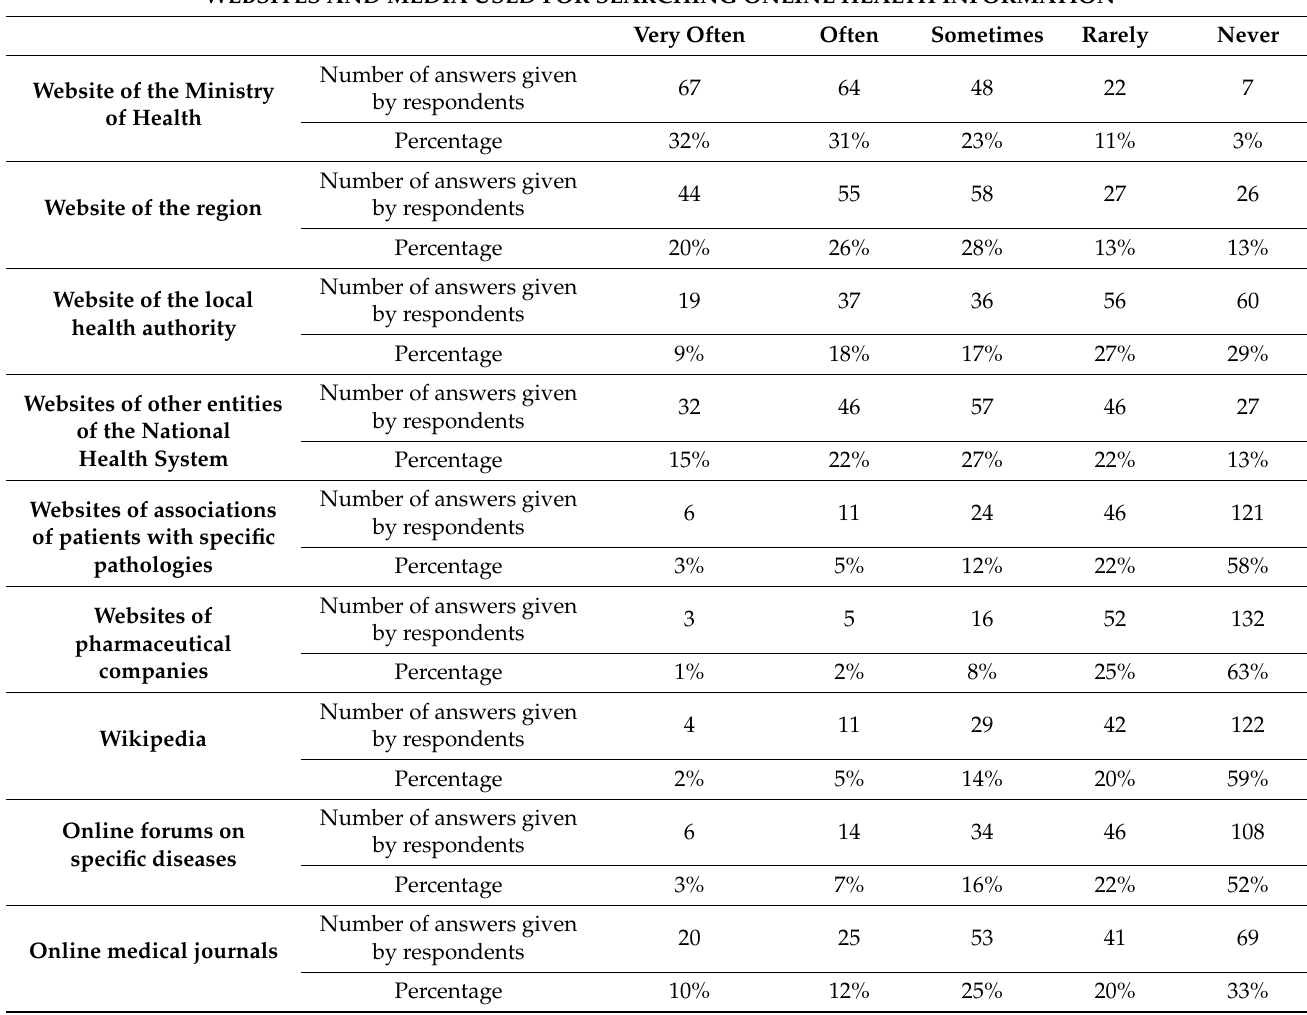
Table 14. Website and media used for searching online COVID-19